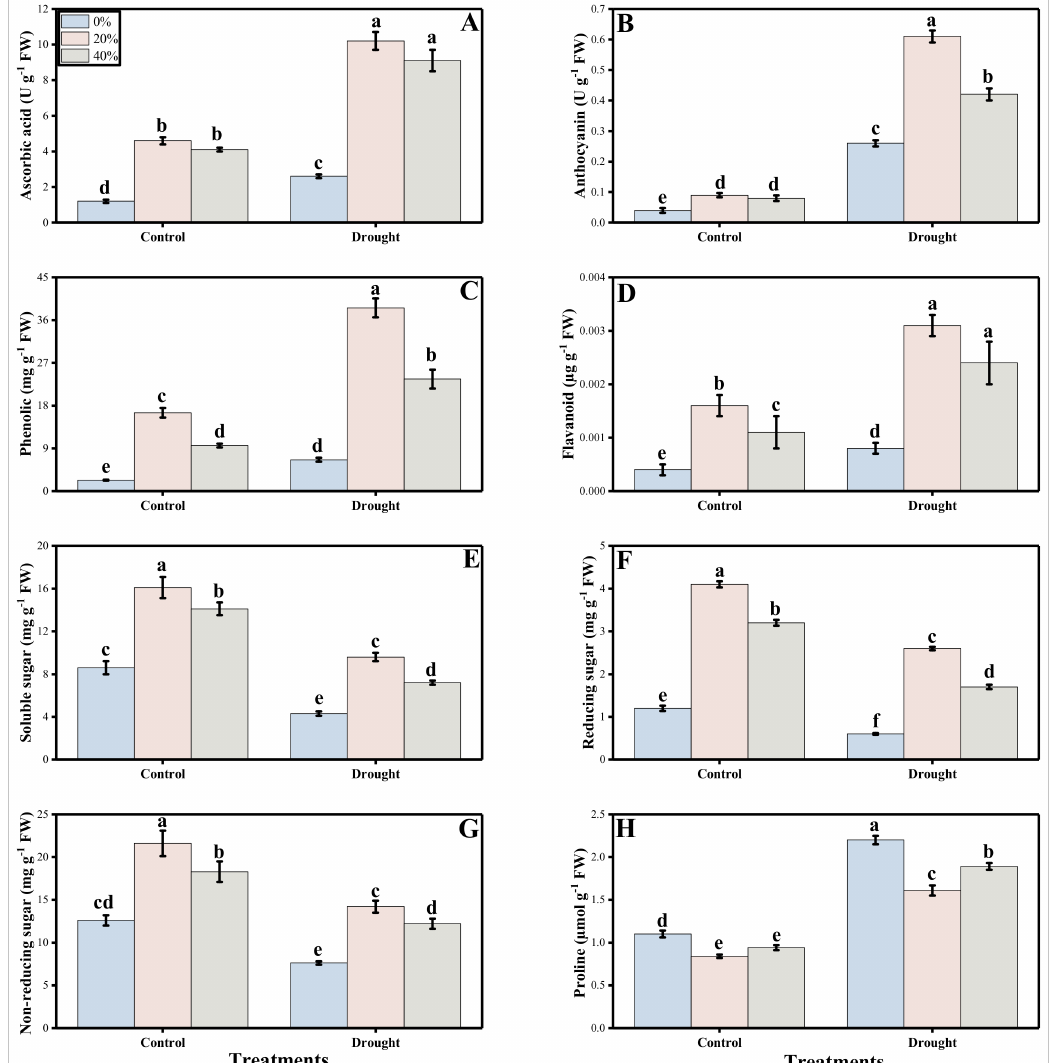
Figure 7. Effect of seed priming with Plantago ovata leaf extract on ascorbic acid contents ( A ), anthocyanin contents ( B ), phenolic contents ( C ), flavonoid contents ( D ), soluble sugar contents ( E ), reducing sugar contents ( F ), non-reducing sugar contents ( G ) and proline contents ( H ) under water stressed and non-stressed environments in maize cultivar Cimmyt − Pak. Means sharing similar letter(s) within a column for each parameter do not differ significantly at p < 0.05. Data in the figures are means of three repeats ( n = 3) of just one harvest of Zea mays plants ± standard deviation (SD). Different lowercase letters on the error bars indicate significant difference between the treatments. Different treatments ( P. ovata extract) used in this study are as follows: 0% (0% P. ovata extract), 20% (20% P. ovata extract) and 40% (40% P. ovata